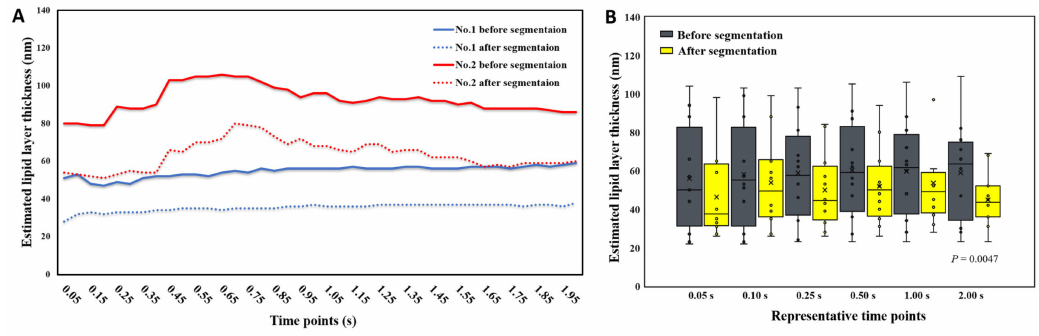
Figure 4. Comparison of the estimated LLT at di ff erent time points before and after image segmentation. ( A ) the serial estimated LLT with time interval 0.05 s from pre- and post-segmented images of patient no. 1 and 2, respectively; ( B ) the estimated LLT at di ff erent time points from pre- and post-segmented LLTs shown by boxplots ( N =